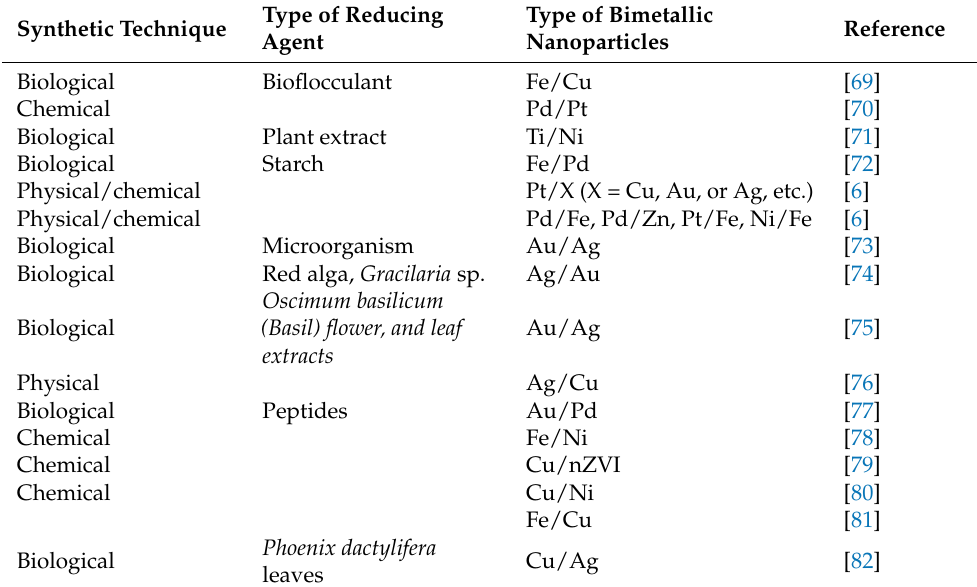
Table 1. Bimetallic nanoparticles synthesized by different methods.